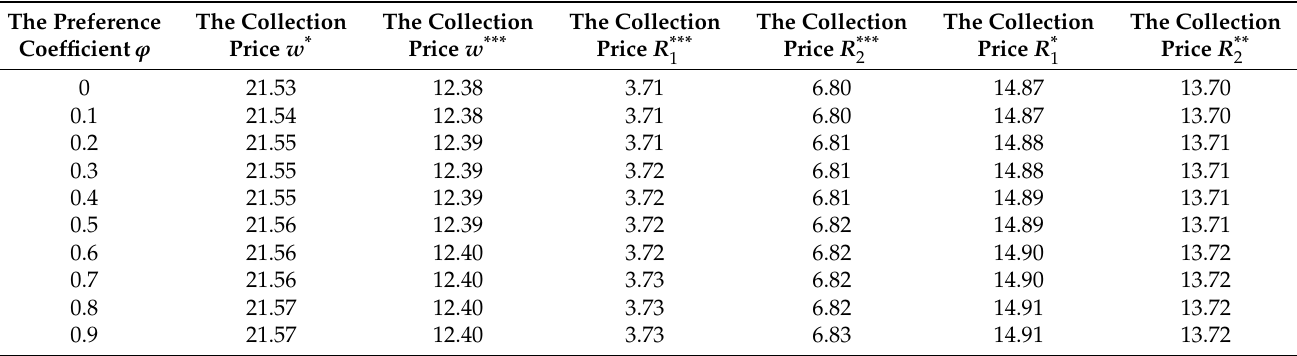
Figure 6. The impact of environmental responsibility η m on the green remanufacturer’s profit π ∗ m , π ∗∗ m , π ∗∗∗ m . Table 2. The relevant data in Figure